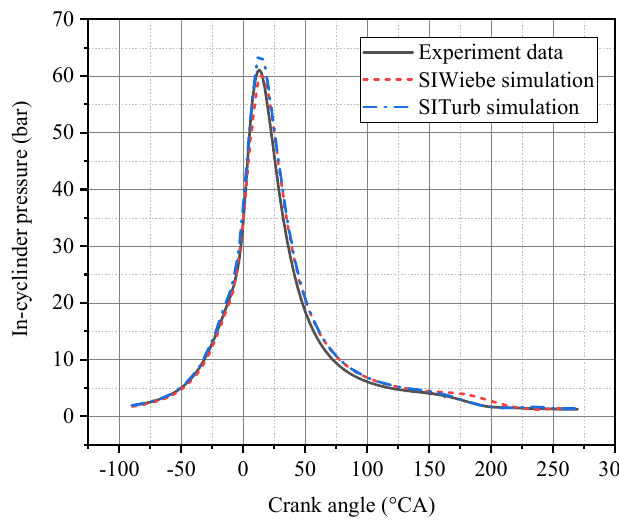
Figure 17. In-cylinder pressure by simulation using SIWiebe and SITurb model in comparison of measured data by experiment (point of operation: n = 3000 rpm, BMEP = 10 bar, CA50 = 8 °CA, intake advance angle = 25 °CA, exhaust retardation angle = 5 °CA).